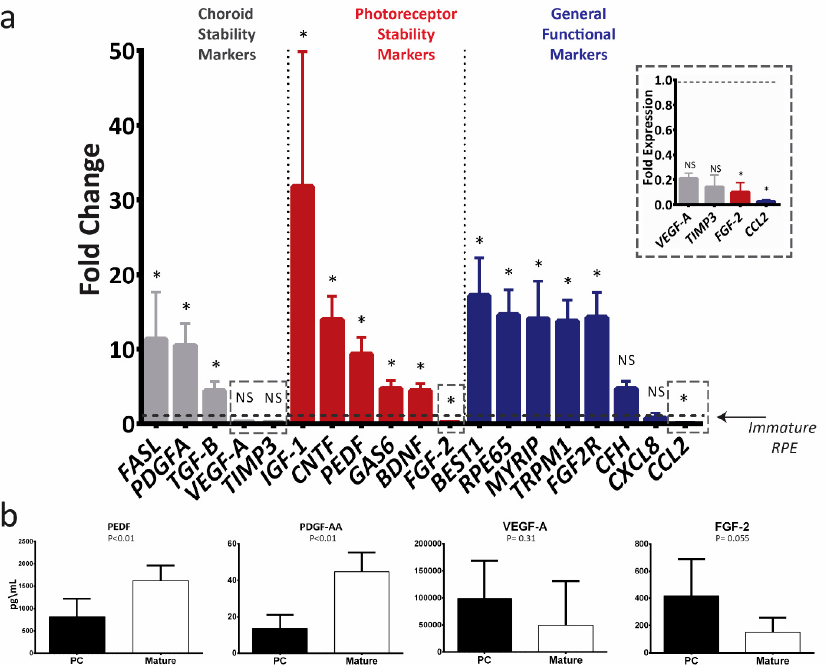
Figure 3. In vitro maturation of ARPE-19 upregulates the expression of therapeutically relevant photoreceptor and choroid trophic factors. ( a ) RT-qPCR analysis of mRNA levels of key RPE genes in mature ARPE-19 cells (>42 days in culture; n = 4). The results were normalized to an endogenous reference gene ( PPIA ) and are presented as mean fold change (2 −ΔΔ CT ) relative to immature ARPE-19 cultures (dotted line) ± standard deviation. Data were compared with a Mann–Whitney U test of Δ Ct values; * p < 0.05; NS: not significant. ( b ) Protein secreted by the post-confluent (PC) immature and mature ARPE-19 cultures into the conditioned media presented as mean concentration ± standard deviation ( n = 5), Mann–Whitney U test. Int. J. Mol. Sci. 2020 , 21 , x CORRECTED PROOF